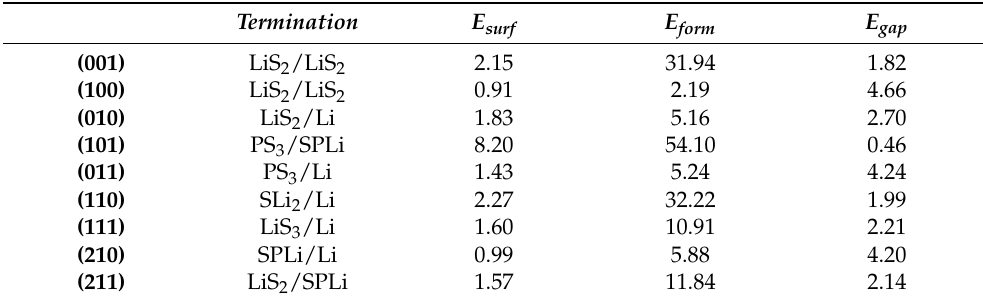
Table 3. Surfaces’ termination (up/down), surface energy ( E surf , in J/m 2 ), formation energy ( E form , in kJ/mol), and band gap ( E gap , in eV) for the nine surfaces of β -Li 3 PS 4 with eight units